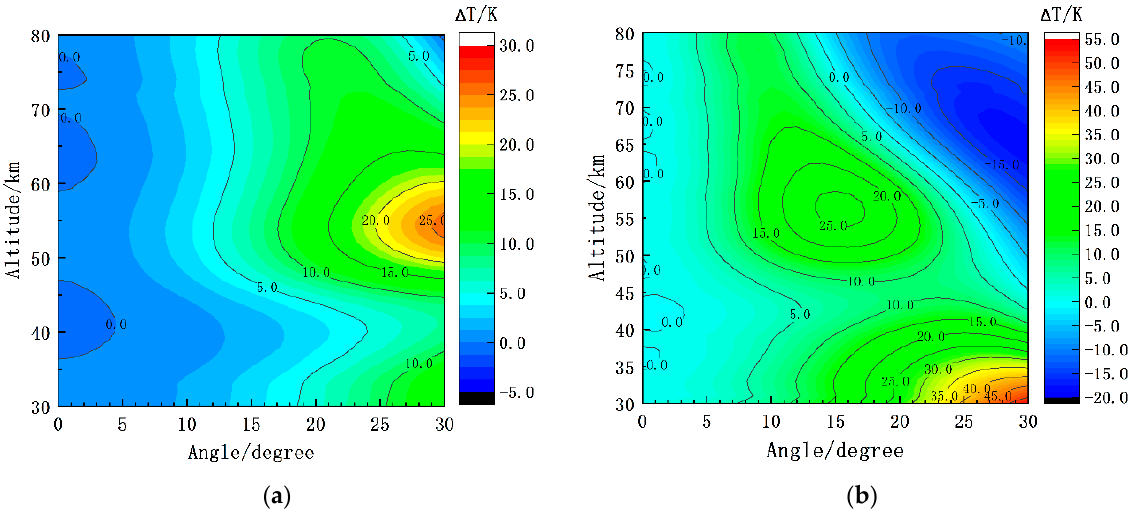
Figure 9. (a) The deviations in temperature vary from 0° to 30° at θ 0 =0°; (b) the deviations in tem- Figure 9. ( a ) The deviations in temperature vary from 0 ◦ to 30 ◦ at θ 0 = 0 ◦ ; ( b ) the deviations in perature vary from 0° to 30° at θ 0 =30°. temperature vary from 0 ◦ to 30 ◦ at θ 0 = 30 ◦ .